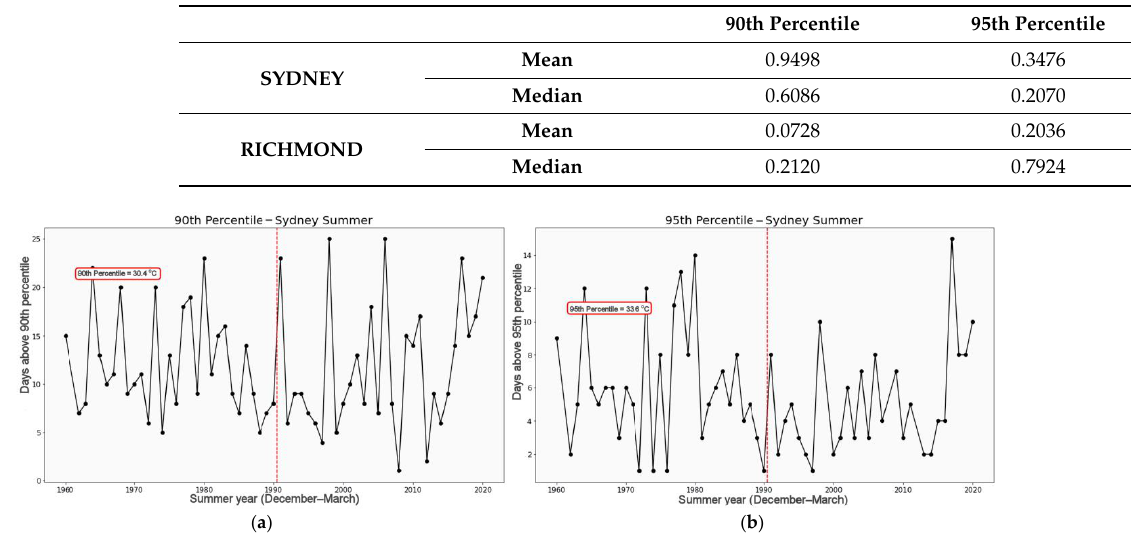
Figure 4. Number of days above the ( a ) 90th percentile and ( b ) 95th percentile across the timeseries for Sydney. The red outlined box denotes the percentile value that is used as the baseline marker and the dotted red line splits the two climate periods.